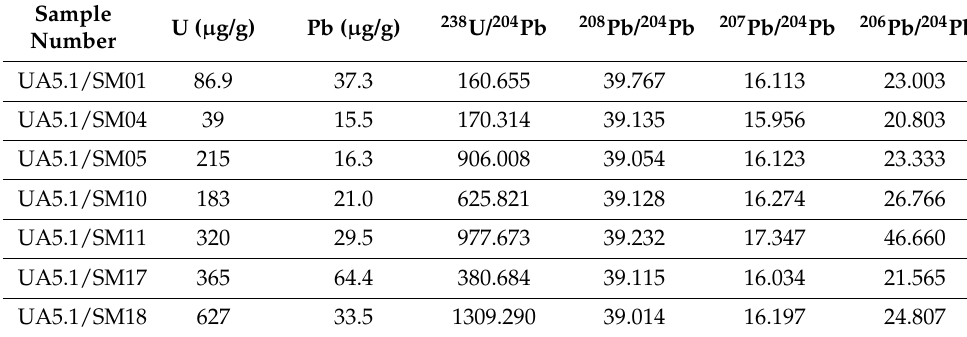
Table 5. Isochron age of U and Pb of ferruginous sandstone in Wajid Basin.